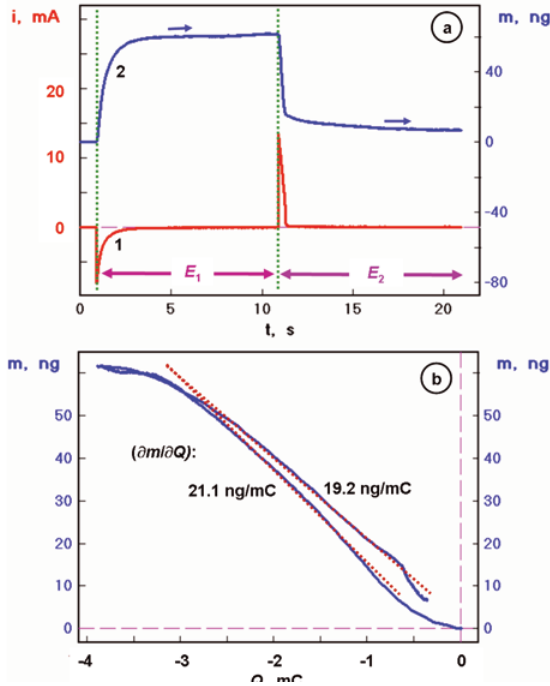
Figure 4. (a) Current (1) and mass change (2) transients, recorded in 10 mM TEAC + 10 mM H between colored and bleached state of a WO previously subjected to dissociative reduction in 100 mM TEAC solution; (b) m-Q